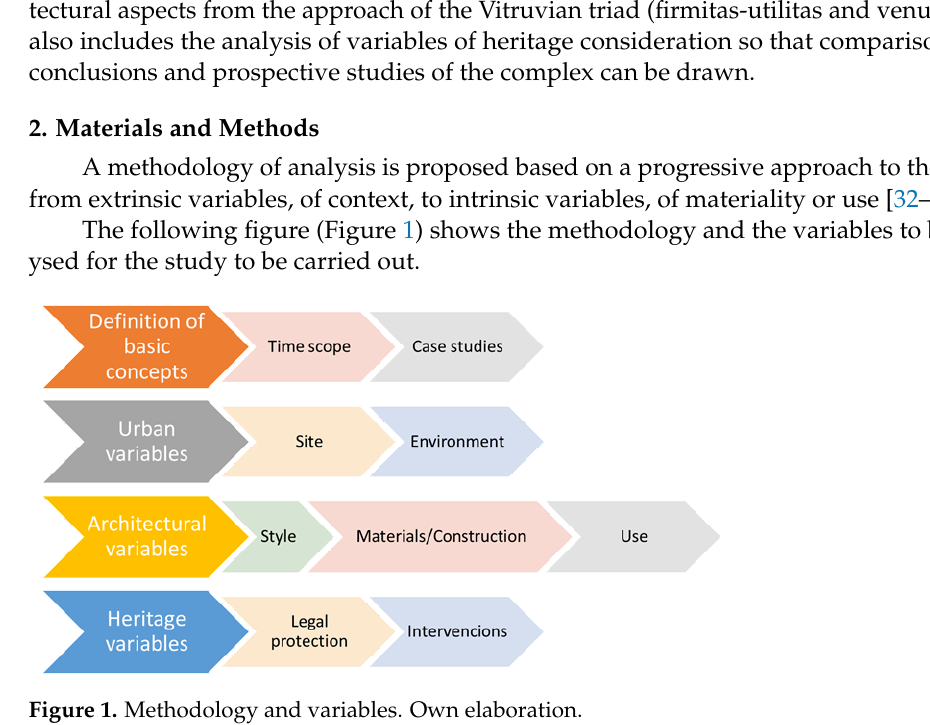
Figure 1. Methodology and variables. Own